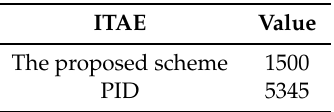
Figure 6. The curves of disturbance estimation under weak disturbance. Table 1. Integrated time and absolute error (ITAE) index under weak